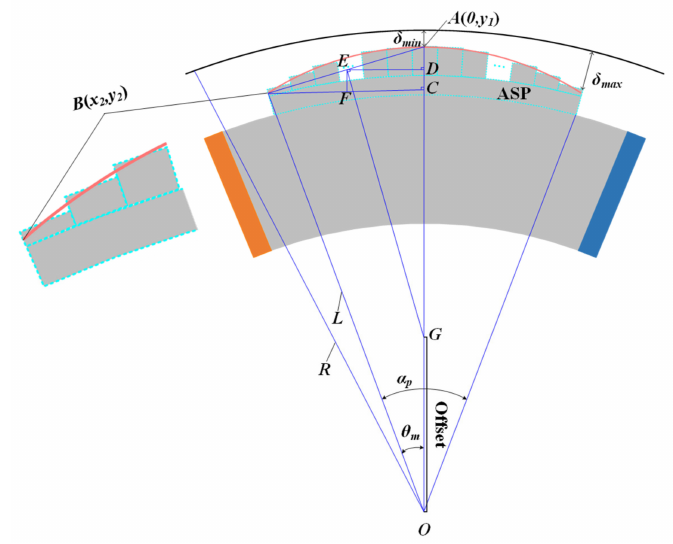
Figure 4. Schematic of offset